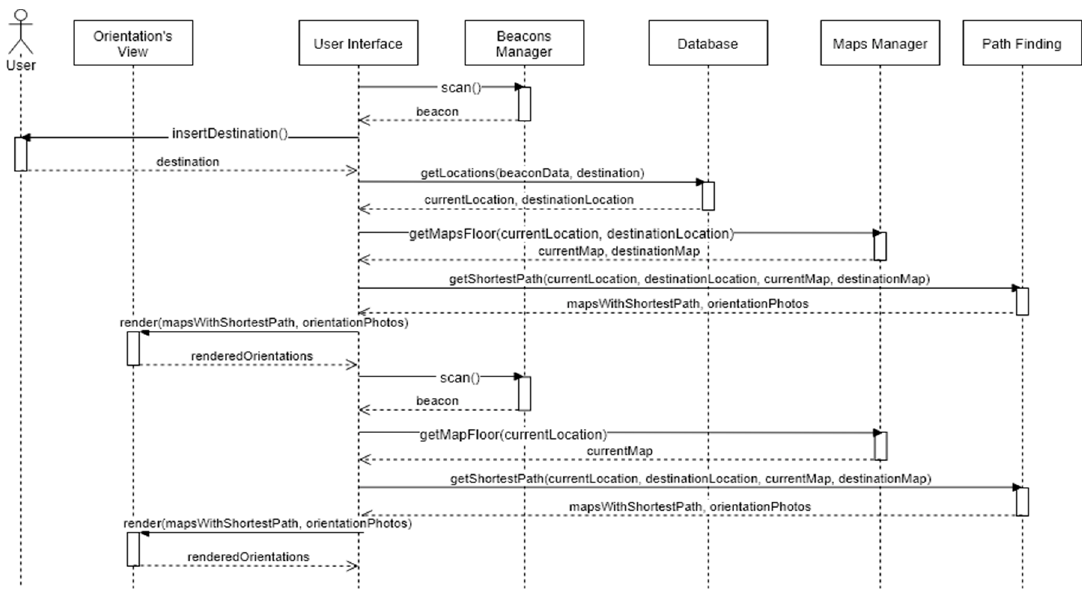
Figure 14. Sequence Diagram of Orientations Process.